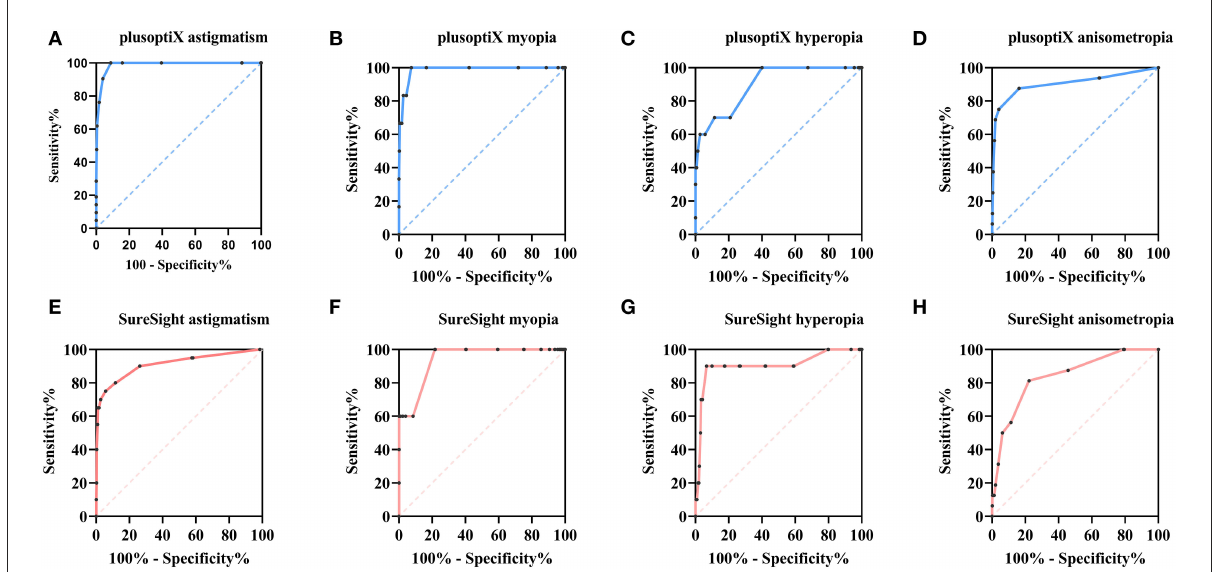
FIGURE2 Receiver operating characteristic (ROC) curve for refractive results obtained by PlusoptiX and SureSight. ROC curve for (A-D) refractive results obtained by PlusoptiX and (E-H) refractive results obtained by